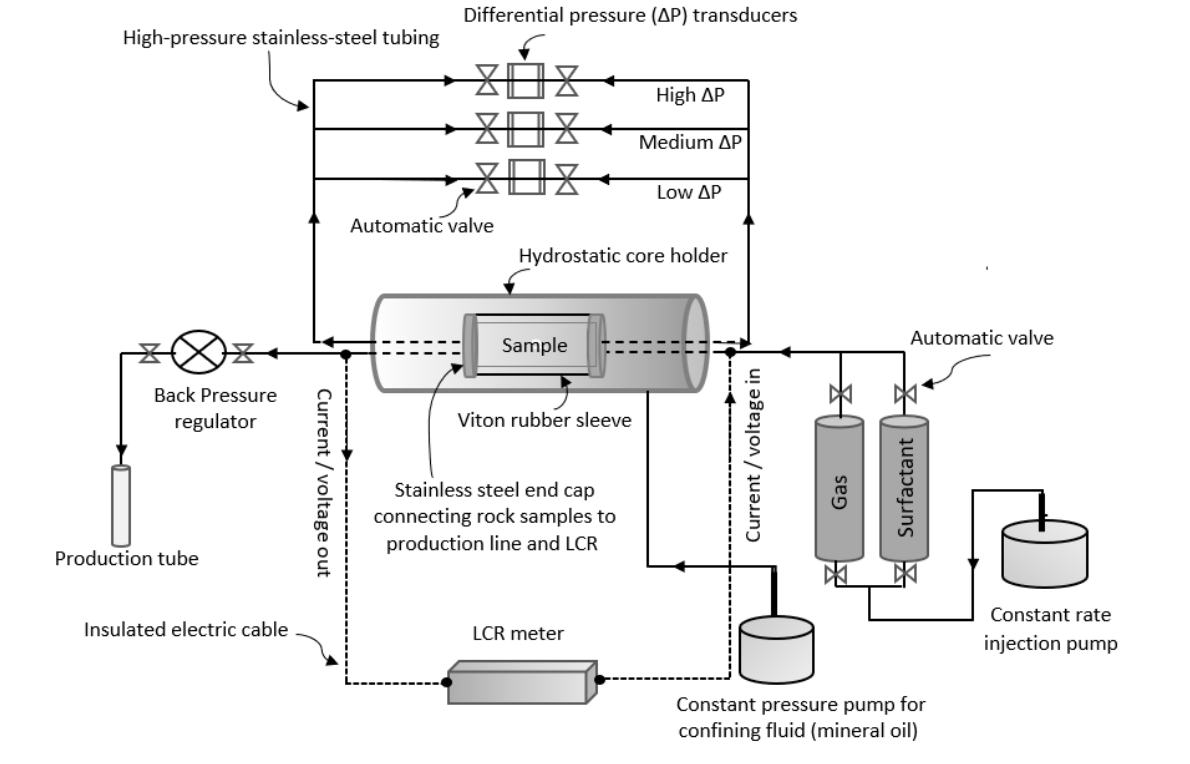
Figure 2. Core flooding system equipped with electrical resistivity measurement system (LCR: inductance–capacitance–resistance). Adapted with permission from [45]. Copyright 2022 Springer Nature Switzerland AG.